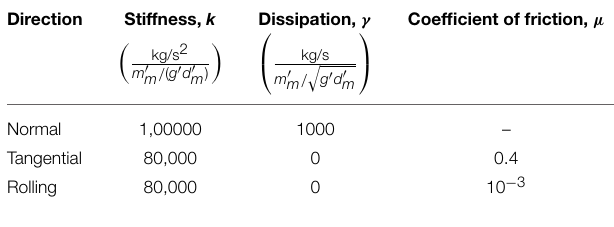
TABLE 1 | Material properties of the spheres. Direction Stiffness, k Dissipation,